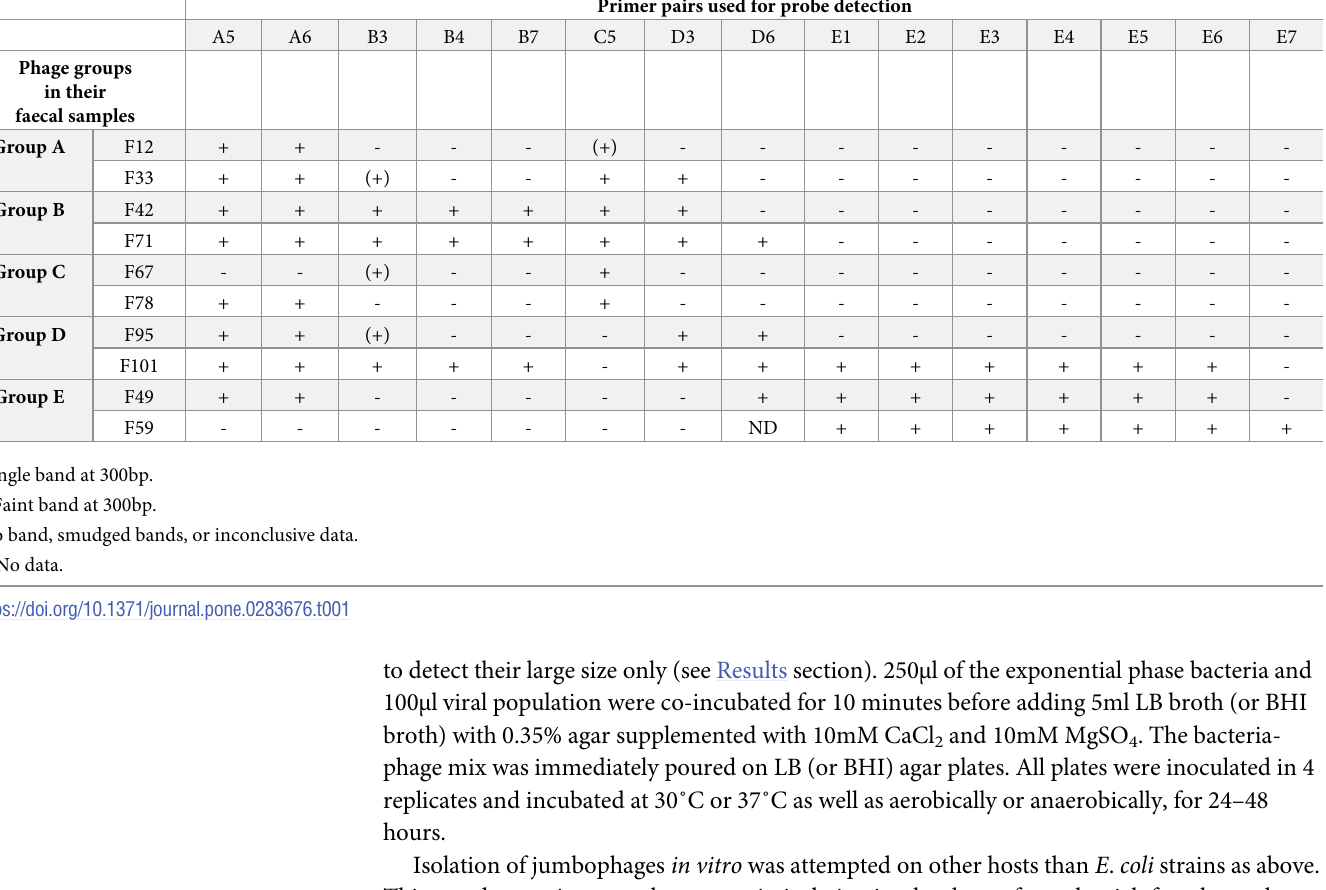
Table 1. Detection of assembled phage genomes in extracted viral population from each faecal sample by PCR amplification. Primer pairs used for probe